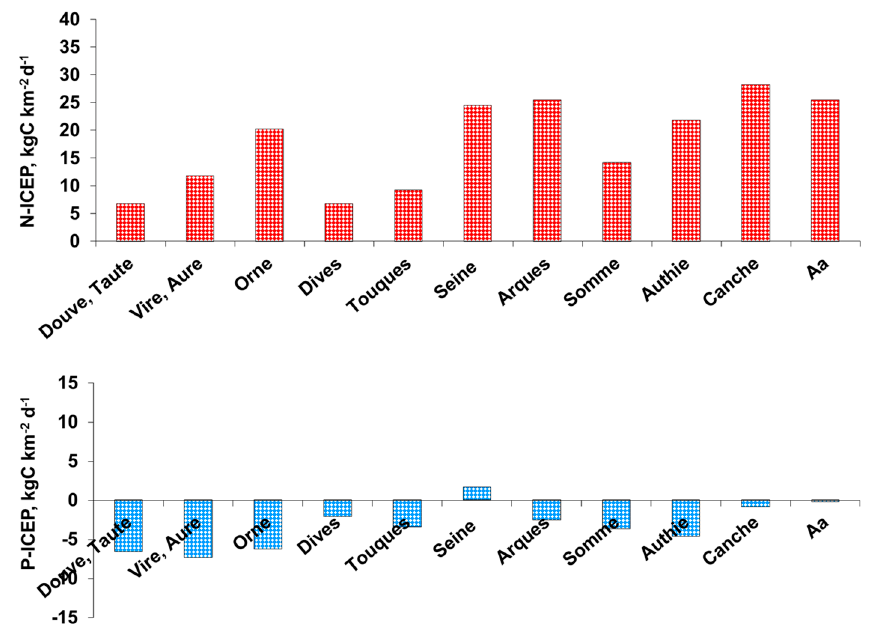
Figure 4. Specific nutrient fluxes at the outlets of the rivers studied and averaged for the reference period, 2002–2014 (total N, P, and Si in kg km − 2 y − 1 ).